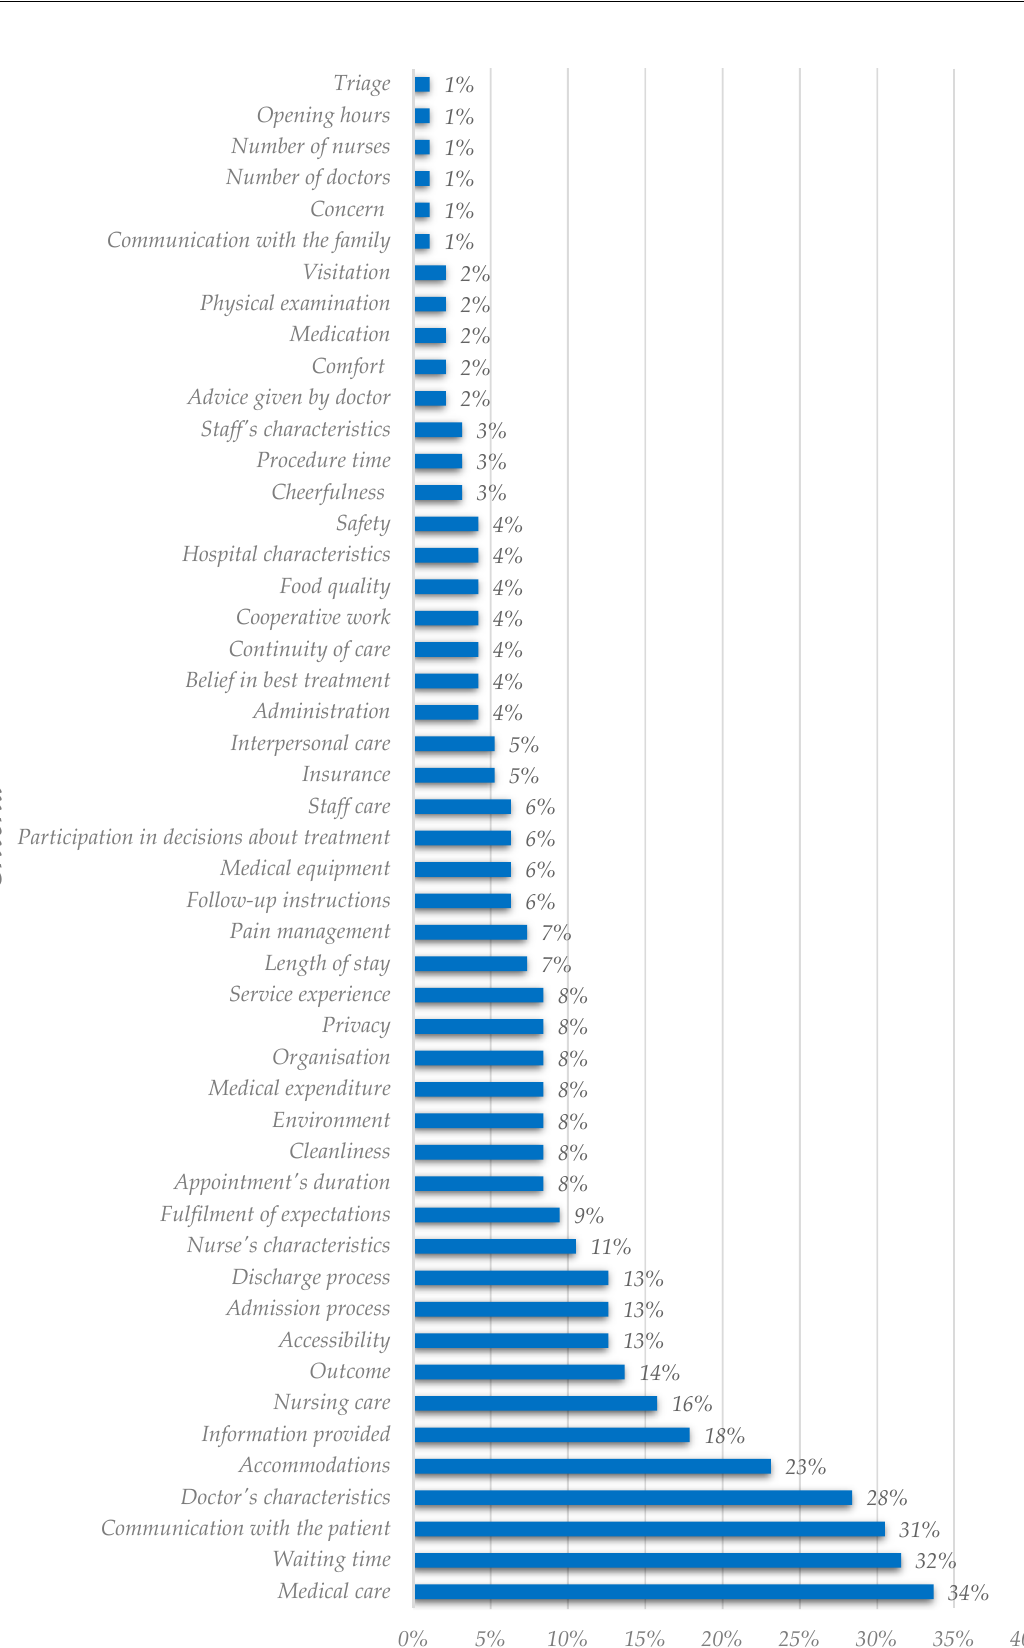
Figure 4. Analysis of criteria deemed as the most critical in the literature (global analysis).